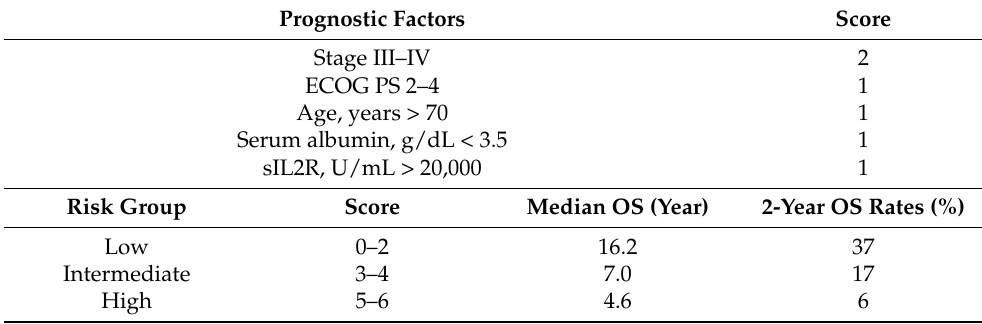
Table 2. Simplified ATL-PI.